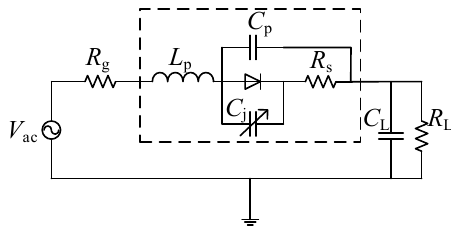
Figure 5. A series configuration with a source and load of a diode circuit model.